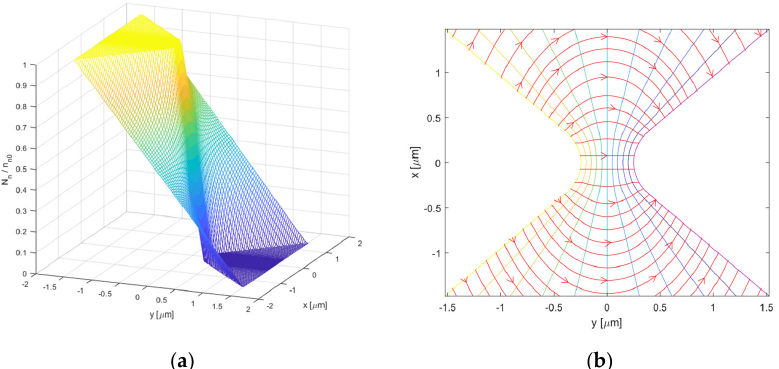
Figure 4. Distribution of excess carriers in the base of the VES-BJT bipolar transistor: ( a ) plot of carrier distribution values (the planes at the top and bottom correspond to the emitter and collector areas, where the yellow surface is the emitter region, the purple surface is the collector region, and, in between, spatial excess carrier distribution is depicted, cf. Figure A1); ( b ) distribution in the plan view with depicted exemplary lines (red lines with arrows) of current paths (collector current) derived by calculating the gradient of the distribution—on the left side is the emitter, and on the right side is the